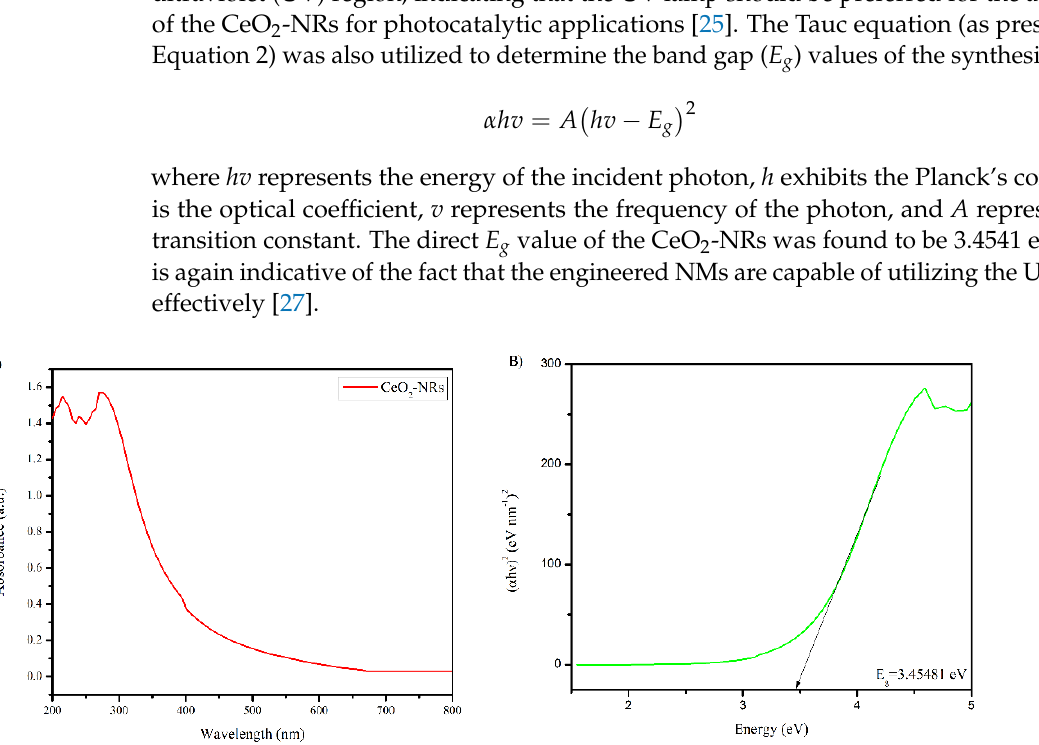
Figure 2. XRD spectrum of CeO 2 -NRs and the standard JCPDS Card no. 00-034-0394.